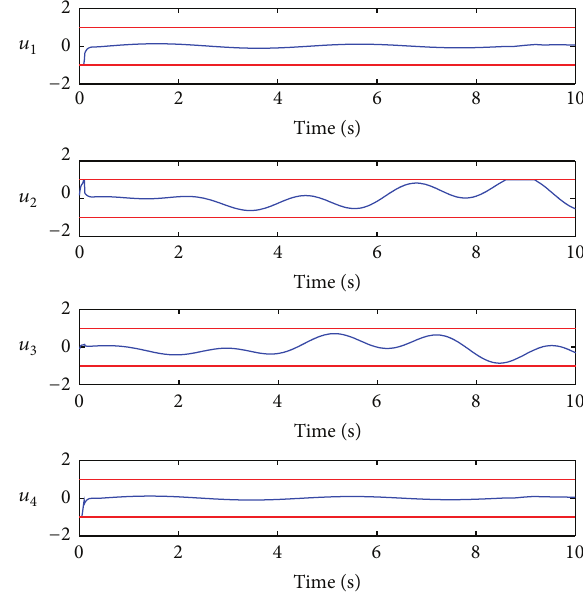
Figure 9: Control input 𝑢